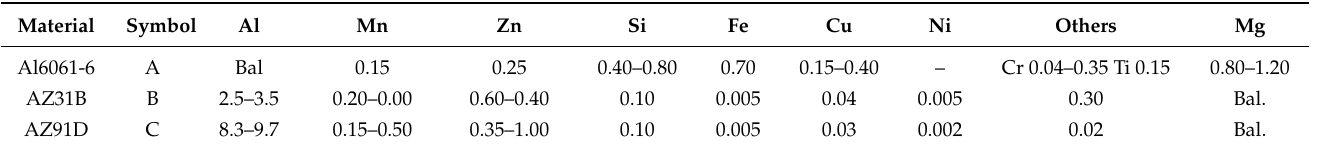
Table 3. Content of Mg and Al alloys (in mass fraction,